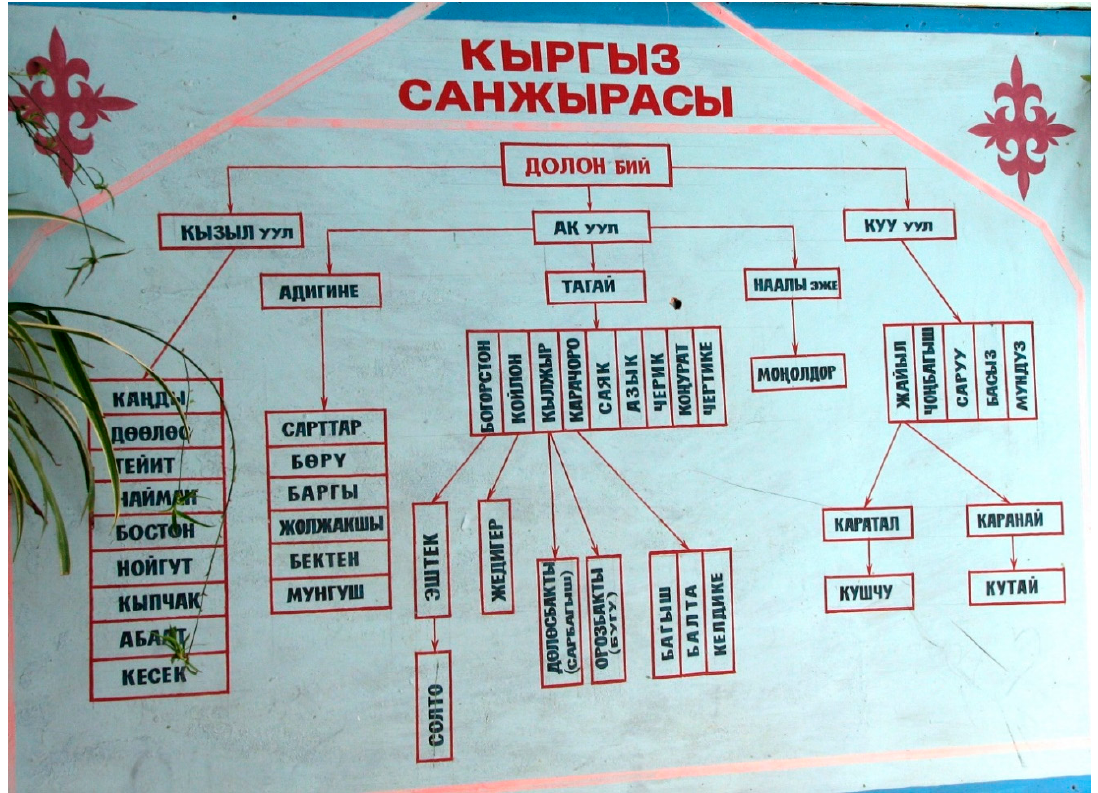
Figure 1. Chart in a Kara Buura middle-school history classroom showing the national Kyrgyz sanjïrasï (“sanjïra of the Kyrgyz”) with the three branches at the top leading to 34 canonical top-level lineages. This common simplification in Kyrgyzstan creates a spectrum of categories rather than detailed chronologies, and implies that the apical ancestors were all within a few generations of one another and closely related. Important uruu in Kara Buura district are Kushchu and Kutay (Kïtay) at the bottom right, along with Saruu in the middle of the group of five above them. Jetigen does not appear in this version.